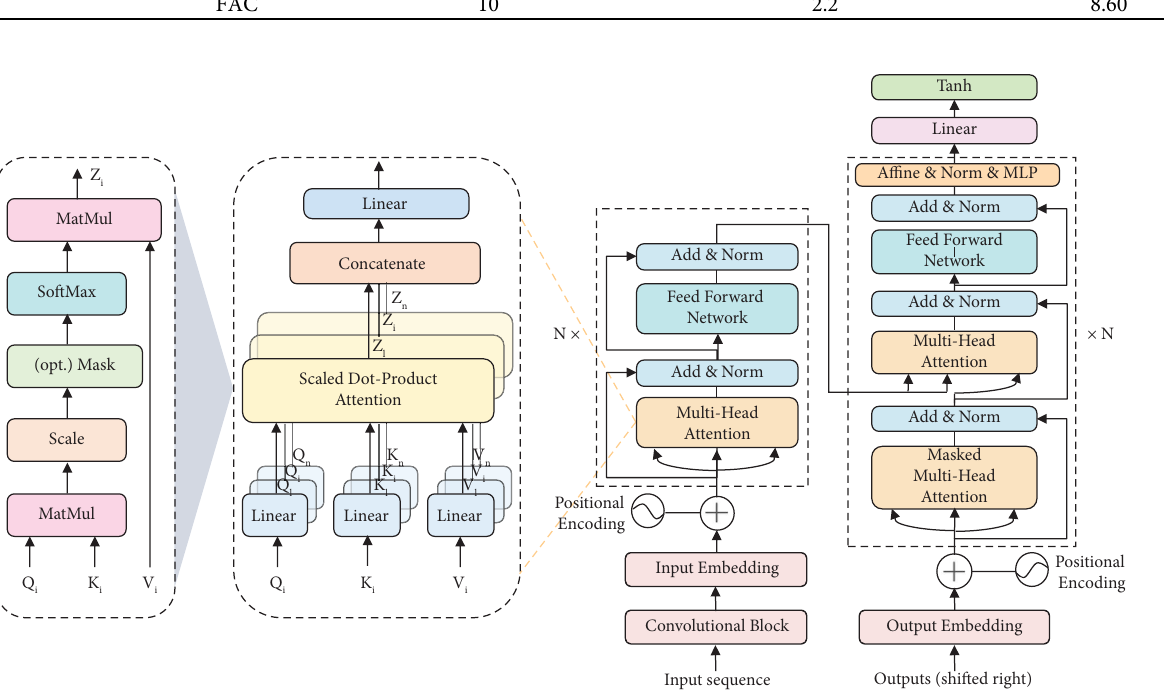
Figure 8: Te architecture of the